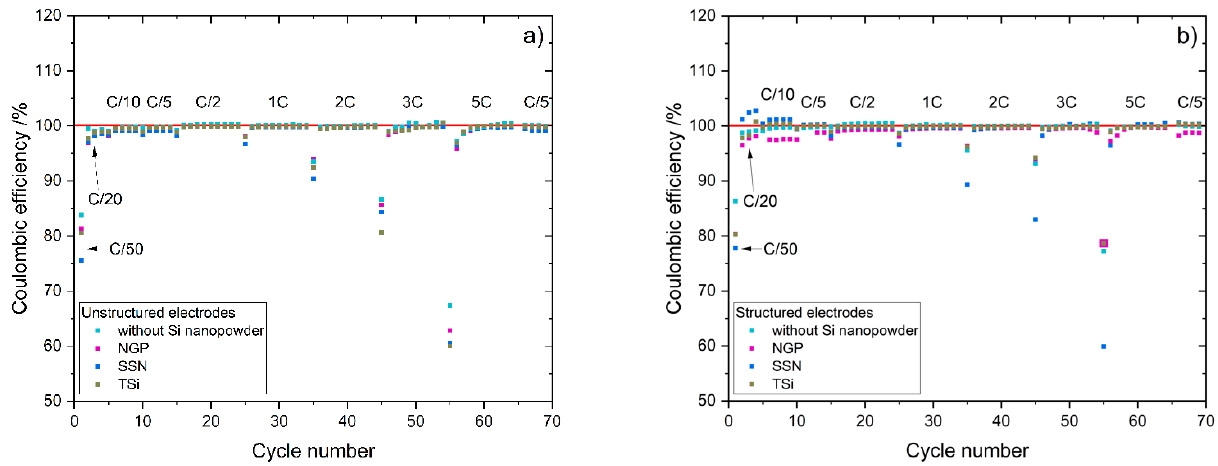
Figure A8. Coulombic efficiency of the pouch cells with ( a ) unstructured electrodes and ( b ) structured electrodes. Table A3. Resistances of the pouch cells after formation and the rate capability test, and at EoL.